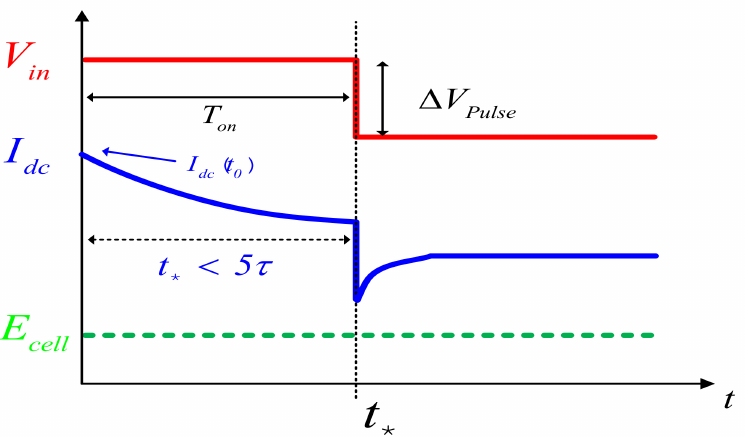
Figure 9. Initial instantaneous charging current when intermittent pulse potential is